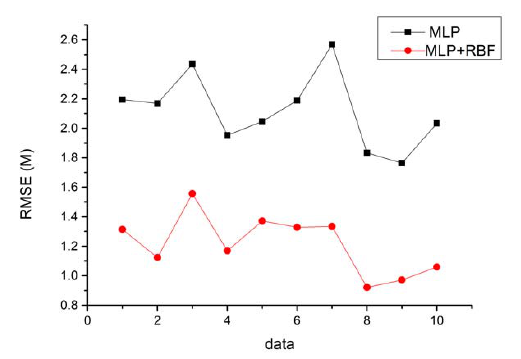
Figure 9. Comparison of RMSE of distance errors between MLP and MLP + RBF.